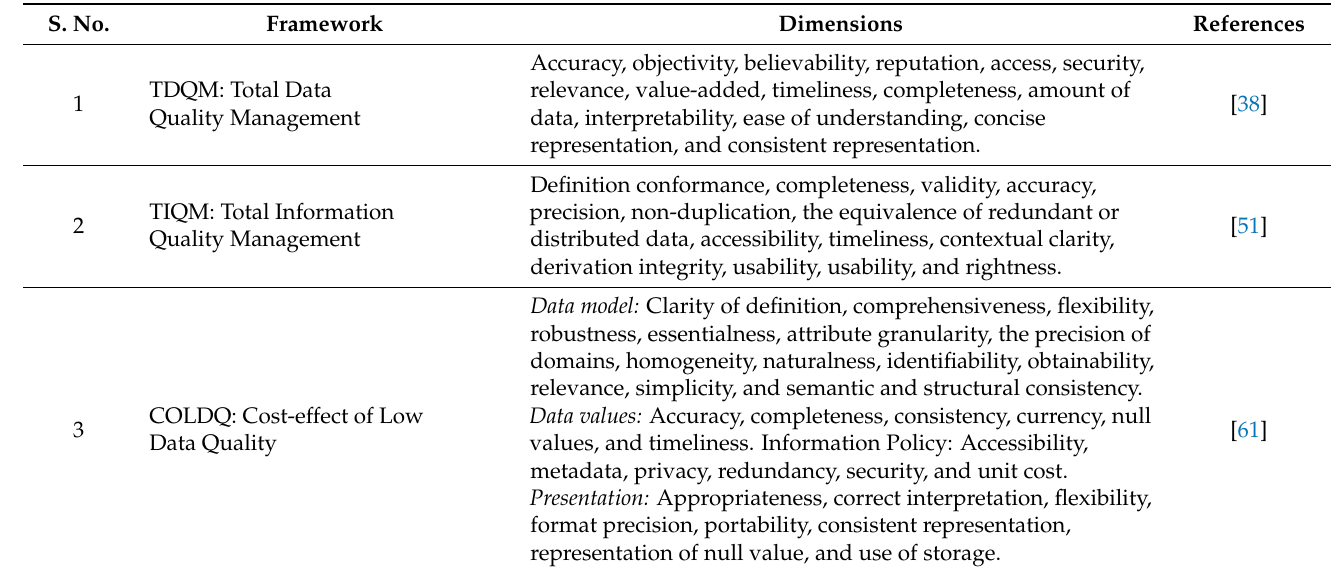
Table 1. Frameworks identified from the literature